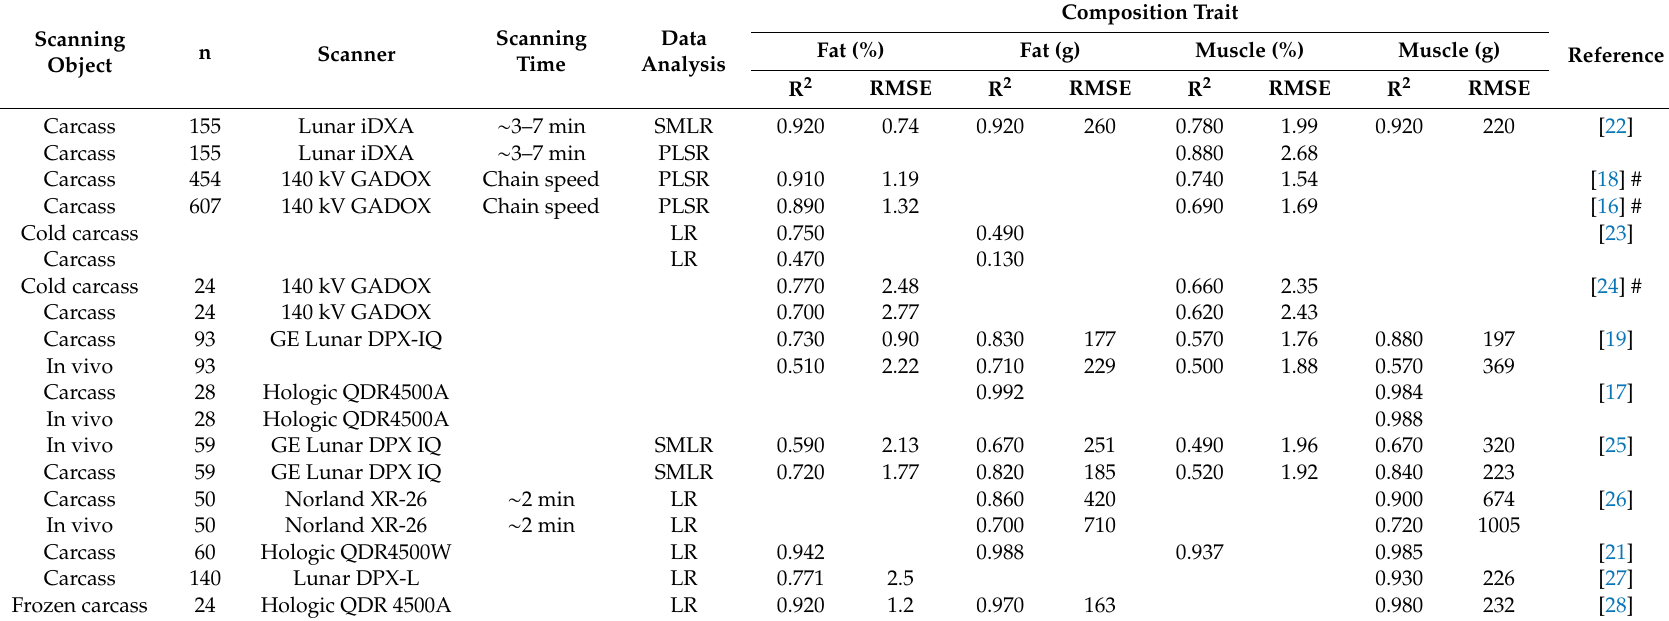
Table 1. Summary of the principal studies to predict fat (% and g) and lean (% and g) of carcass and in vivo of sheep using